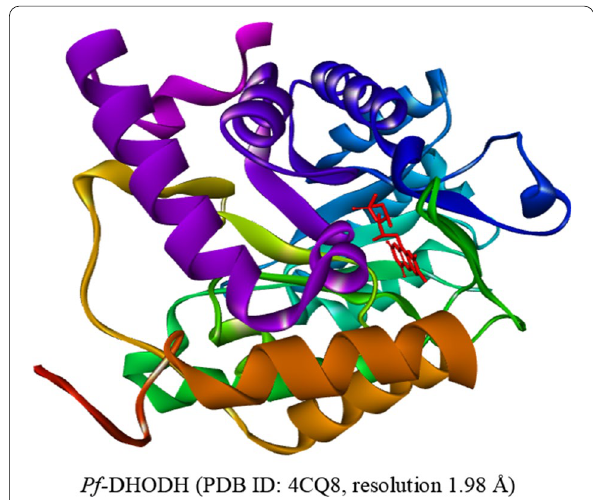
Fig. 2 Derivatives of 2-anilino 4-amino substituted quinazolines (red) in the binding sites of Pf-